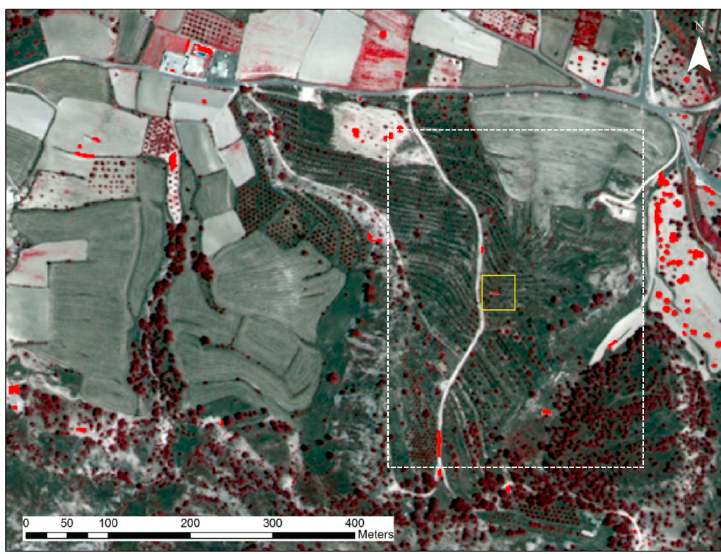
Figure 11. Object-oriented segmentation and classification of the WorldView-2 satellite image. The white rectangle shows the area of the necropolis under examination , while the yellow square shows the looting mark.